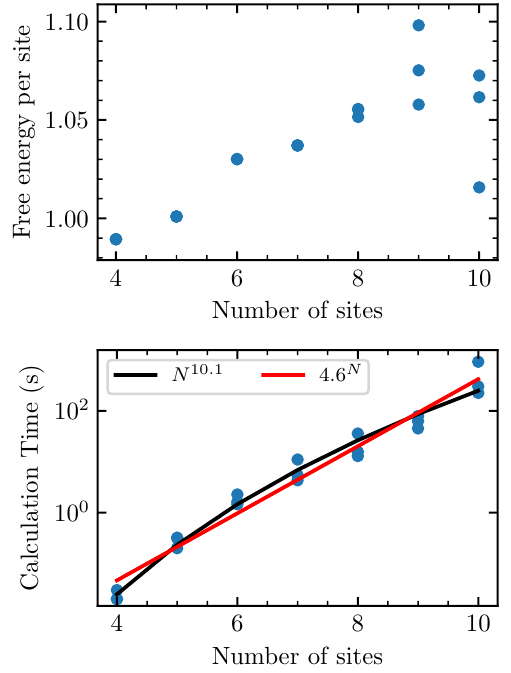
Figure 30: The free energy per site from PyTNR (top) and computation time (bottom) for the dilute Ising glass as a function of N . Bonds were assigned randomly to either = 1 or J = 0, with a fixed number of the former equal to (cid:98) Nk (cid:99) . The samples J ij ij shown used k =